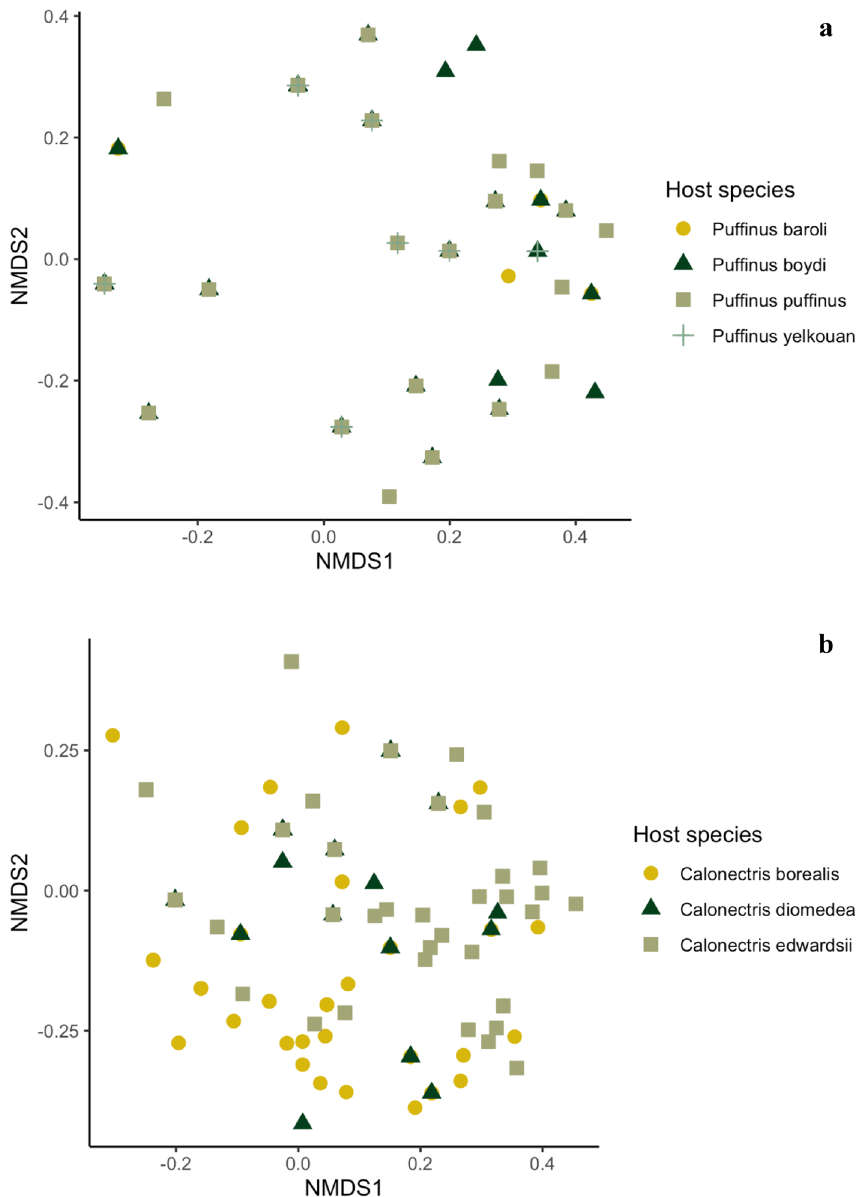
( b ) three species of Calonectris . Although the graph suggests no clear structure of mite infracommunities by host species, the PERMANOVA indicated significant differences in feather mite infracommunity composition in both genera. Data were pooled when host species were sampled in different areas (see Table